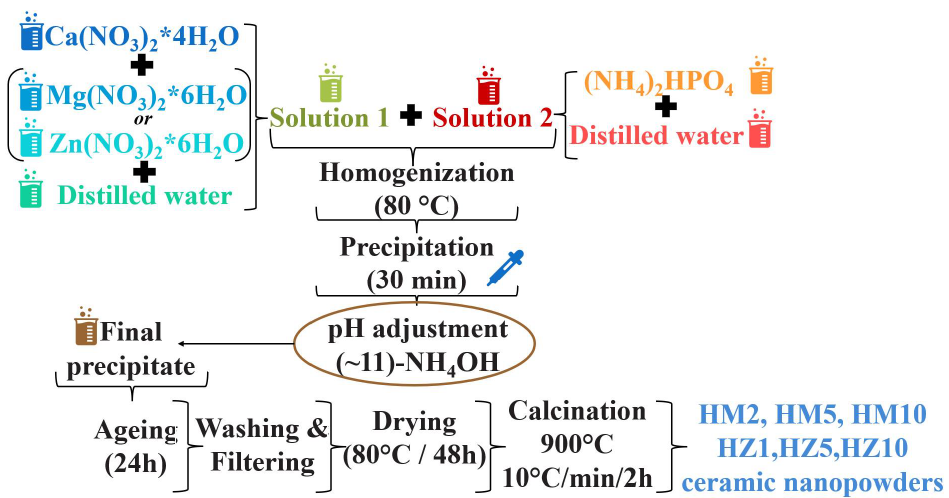
Figure 1. Scheme for HA nanopowders doped with magnesium ions (HM2, HM5, and HM10) and zinc ions (HZ1, HZ5, and HZ10) obtained by precipitation reactions.